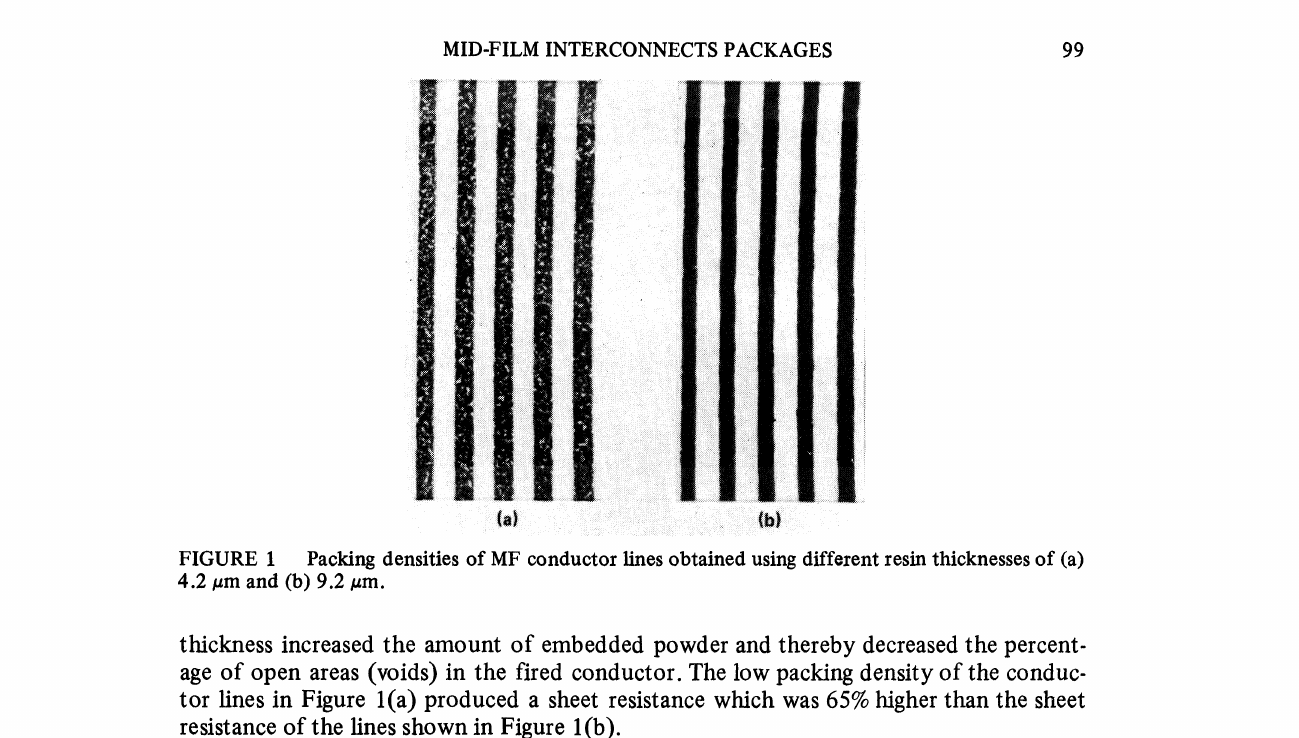
FIGURE 1 Packing densities of MF conductor lines obtained using different resin thicknesses of (a) 4.2 #m and (b) 9.2 #m.